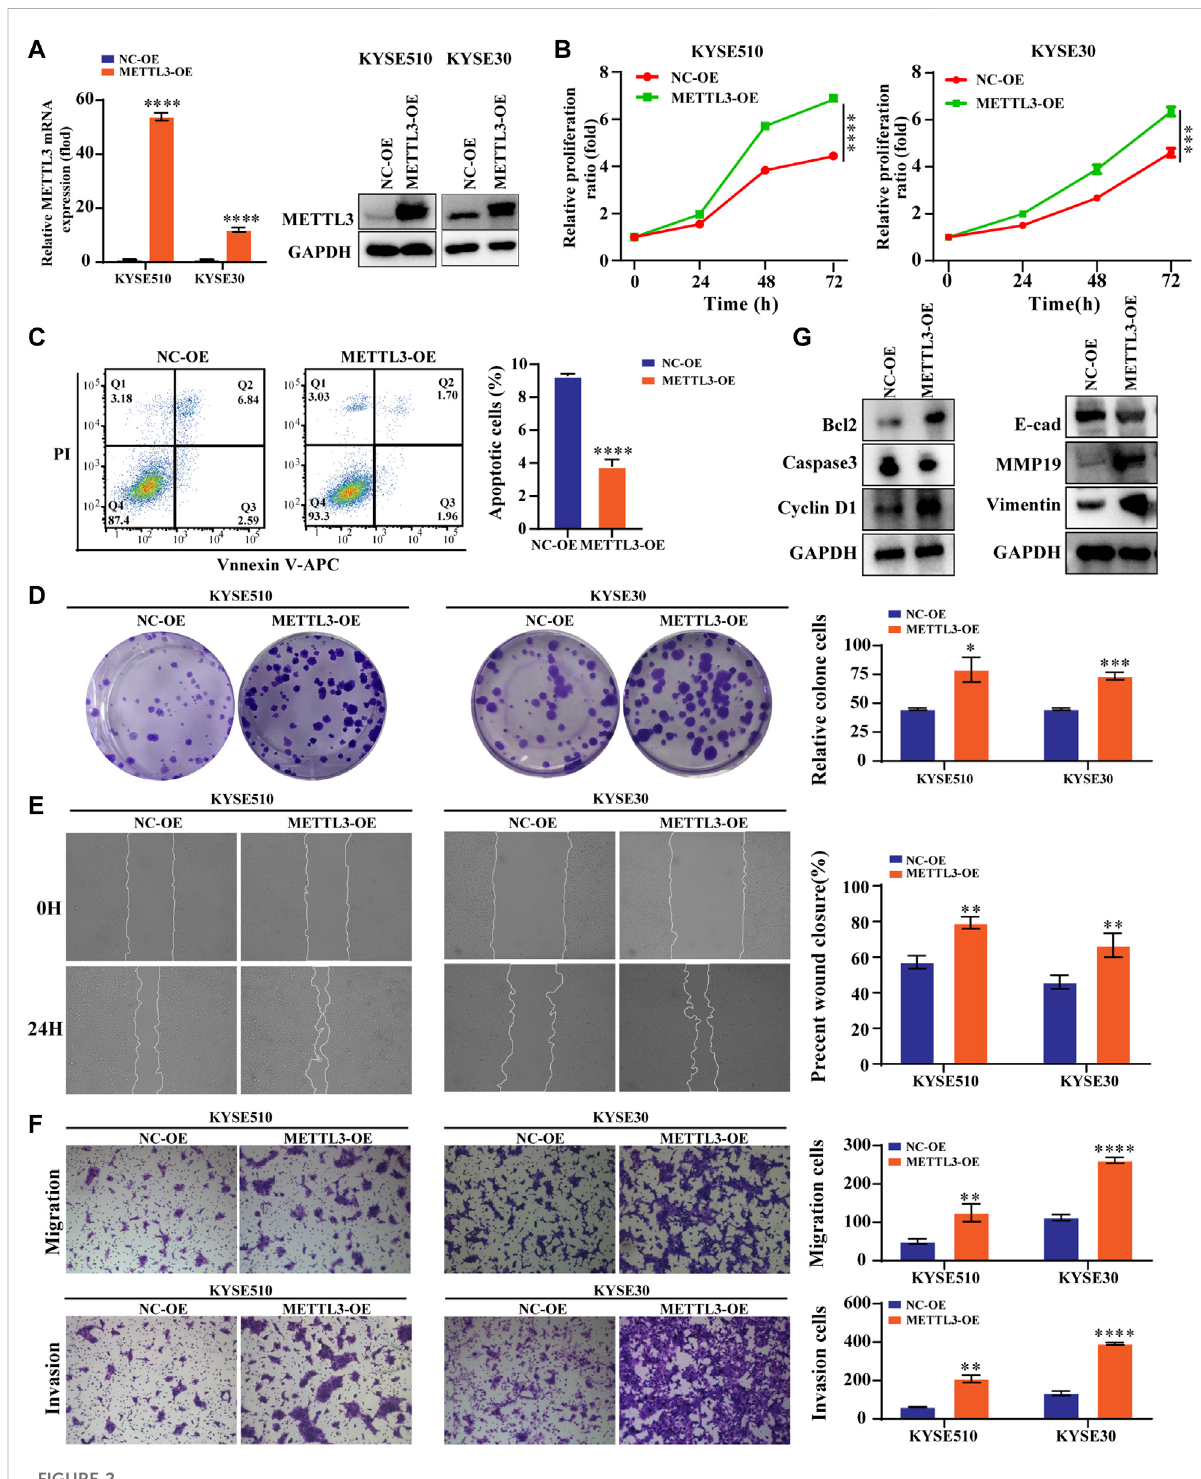
FIGURE 2 High METTL3 expression is associated with proliferation, apoptosis, migration and invasion in ESCC cells (A) . METTL3 mRNA and protein levels were drastically elevated following lentiviral transfection of KYSE510 and KYSE30 cells. (B) . The CCK-8 assay assessed the proliferation ability of METTL3- overexpressing KYSE510 and KYSE30 cells. (C) . Flow cytometric analysis was conducted to assess apoptosis in KYSE510 METTL3-overexpressing cells. (D) .Theclonalityof KYSE510andKYSE30cellswasmeasuredbytheplateclone. (E) . Thewoundscratchtest and (F) .Transwell migrationandinvasion assayswereconductedtoexaminethemigratoryandinvasioncapacitiesofKYSE510andKYSE30cellsoverexpressingMETTL3. (G) .ExpressionofE-cadherin, MMP19 and Vimentin proteins was detected via western transfer in METTL3-overexpressing cells. The protein levels of Bcl2, Caspase 3 and Cyclin D1 were detected by western blotting in METTL3-overexpressing cells. * p < 0.05, ** p < 0.01, *** p < 0.001, **** p <